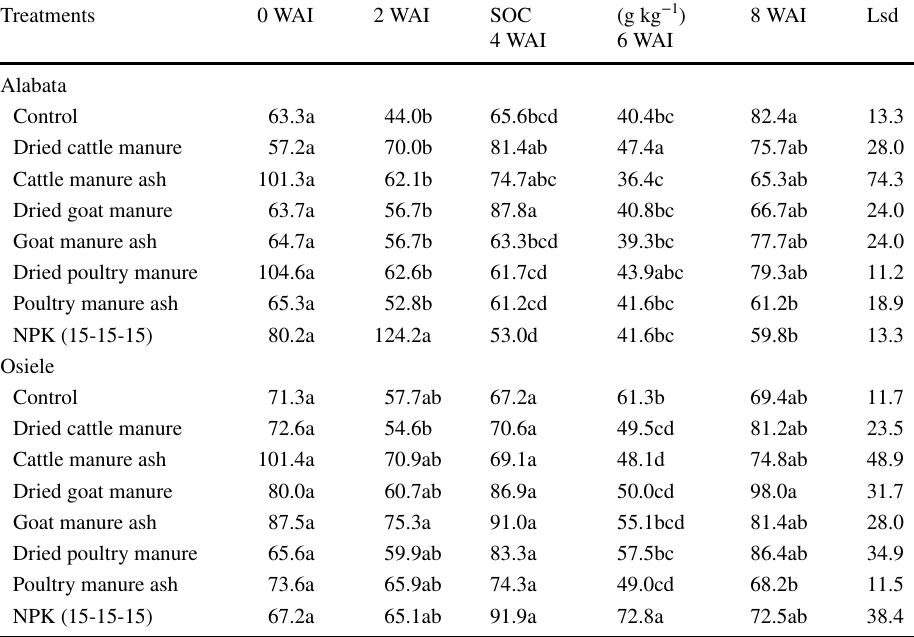
Table 2 Effect of amendments and incubation time on soil organic carbon (SOC) of soils from Alabata and Osiele